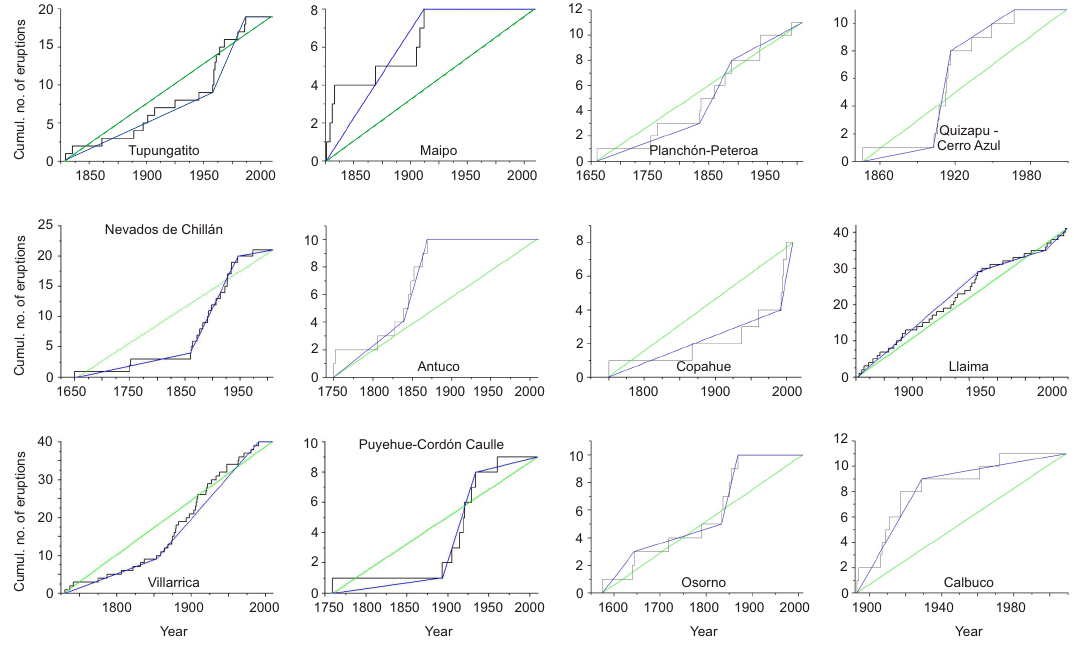
Fig. 2. Cumulative number of eruptions (VEI ≥ 2) as a function of time. Blue lines: piecewise-linear approximation, showing individual eruption regimes/episodes. Green lines: approximation for constant eruption rate. These lines are meant exclusively as an aid to guide the eye and not as a basis for the statistical